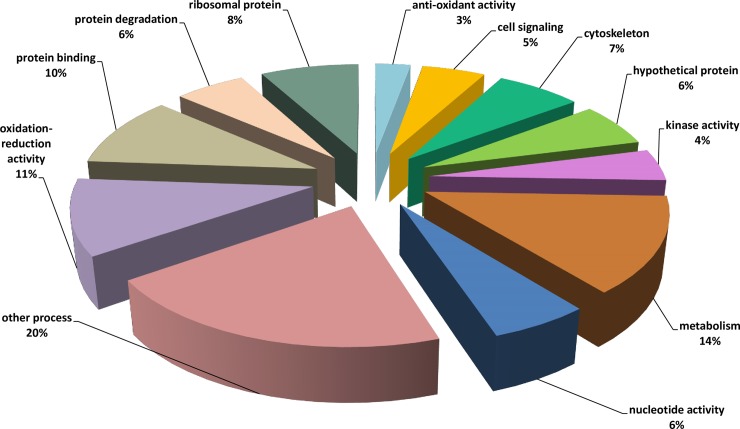
Pie-chart displaying the proteins identified in the H. meleagridis exoproteome sorted according to their biological process.The proteins were categorized into 12 groups termed as: anti-oxidative stress, cell signalling, cytoskeletal, hypothetical protein, kinase activity, metabolism, nucleotide activity, other processes, oxidation-reduction activity, protein binding, protein degradation and ribosomal protein.